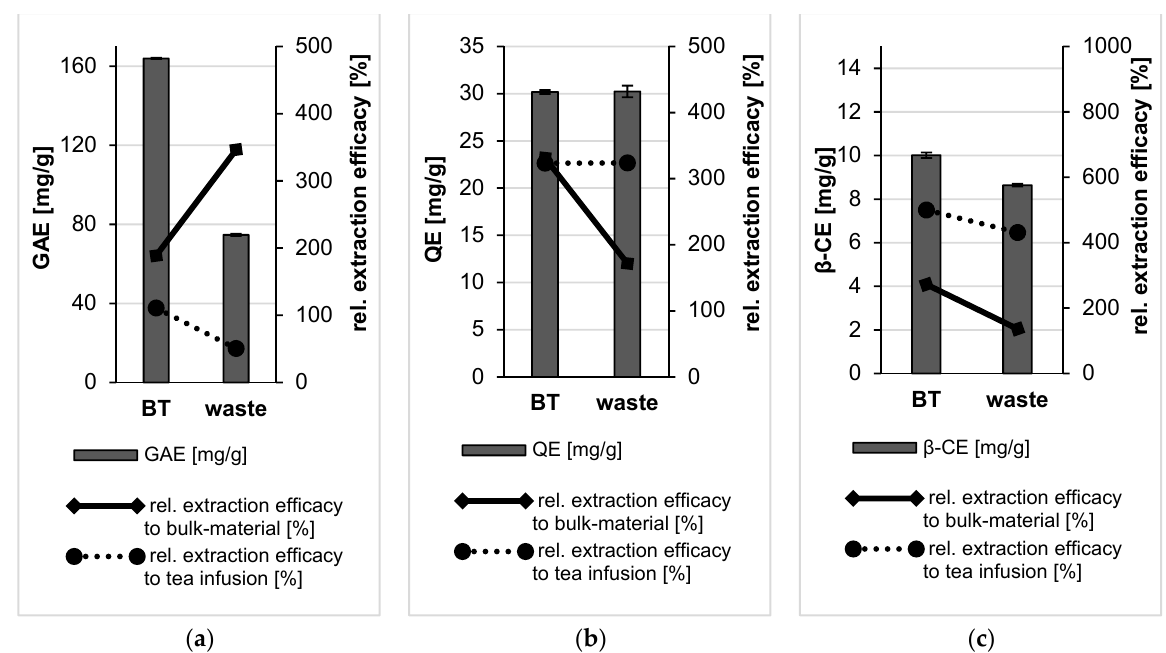
Figure 9. Determination of total polyphenol ( a ), flavonoid ( b ) and carotenoid contents ( c ) of the PlantCrystals from BT leaves and their waste. The polyphenol content is expressed in gallic acid equivalents (GAE), the flavonoid content is expressed in quercetin equivalents (QE) and the carotenoid content is expressed in β -carotene equivalents ( β -CE).